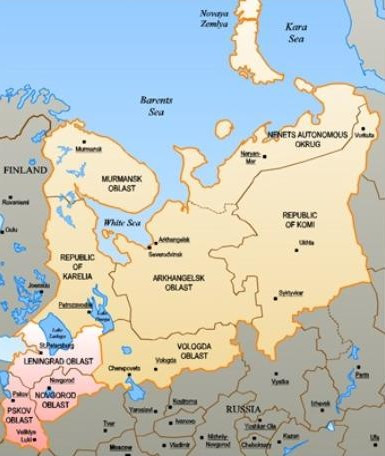
North-western Russia [17].